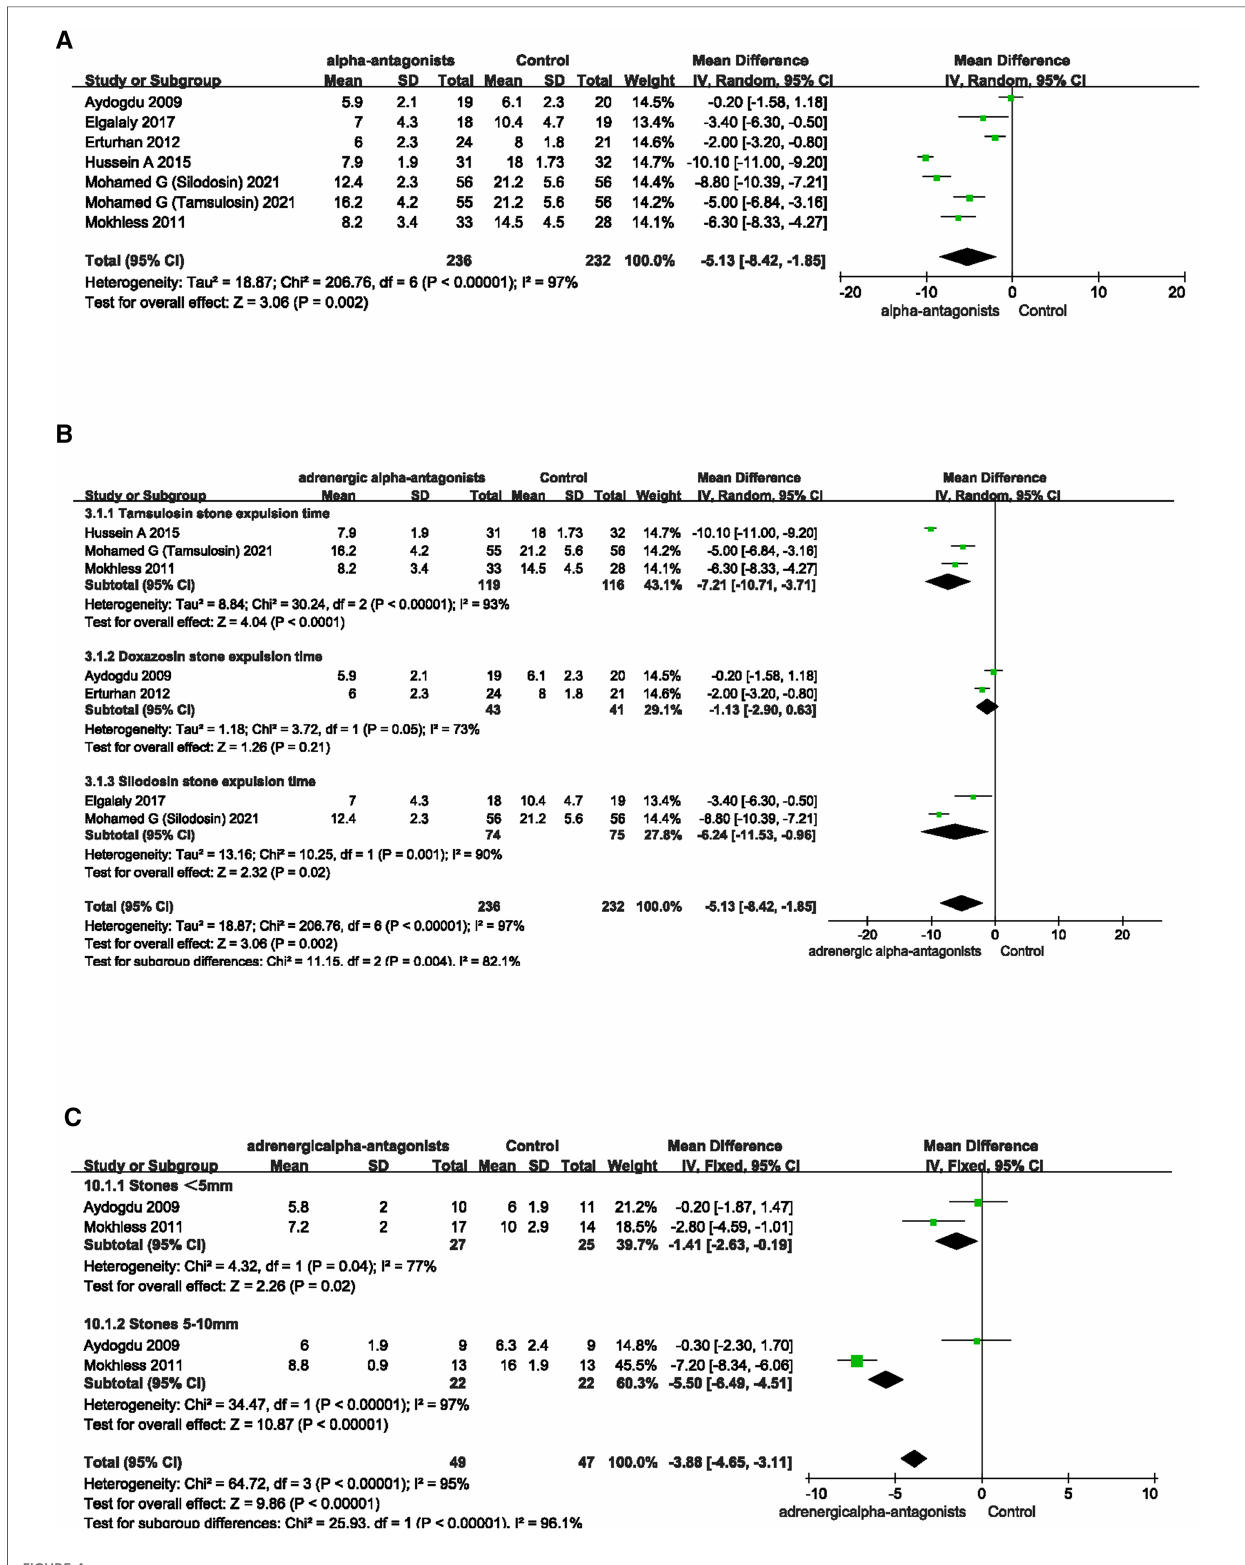
FIGURE 4 Forest plot comparing changes in ureteral calculi exclusion time between adrenergic alpha-antagonists and control groups. ( A ) Effects of treatment with adrenergic alpha-antagonists on ureteral calculi expulsive time compared with control group. ( B ) Subgroup analysis of effects of adrenergic alpha- antagonists on the ureteral calculi expulsive time. ( C ) Subgroup analysis of effects of adrenergic alpha-antagonists on the expulsive rate of ureteral calculi of different